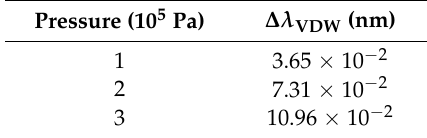
Table 3. Theoretical van der Waals (VDW) width for 4d – 2p H- β for three values of pressure.